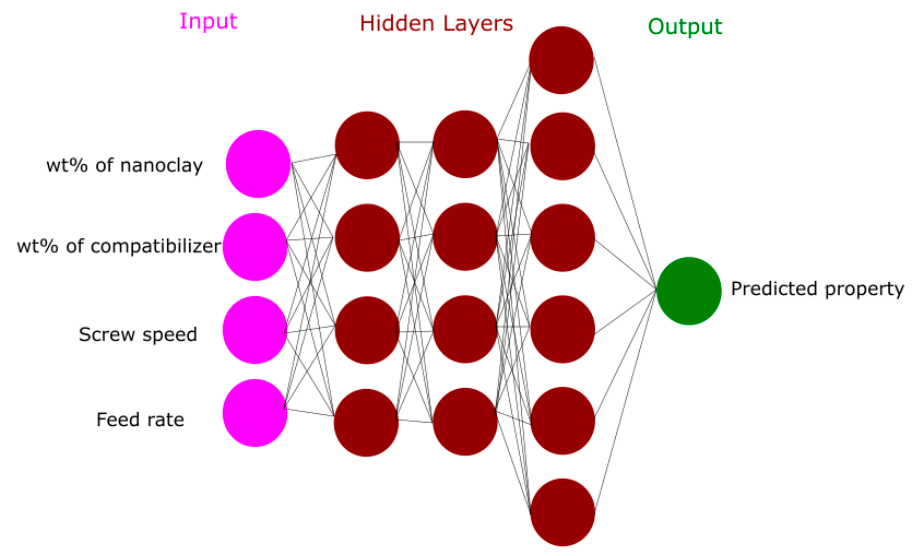
Figure 1. An example of the deep neural network (DNN) structure.